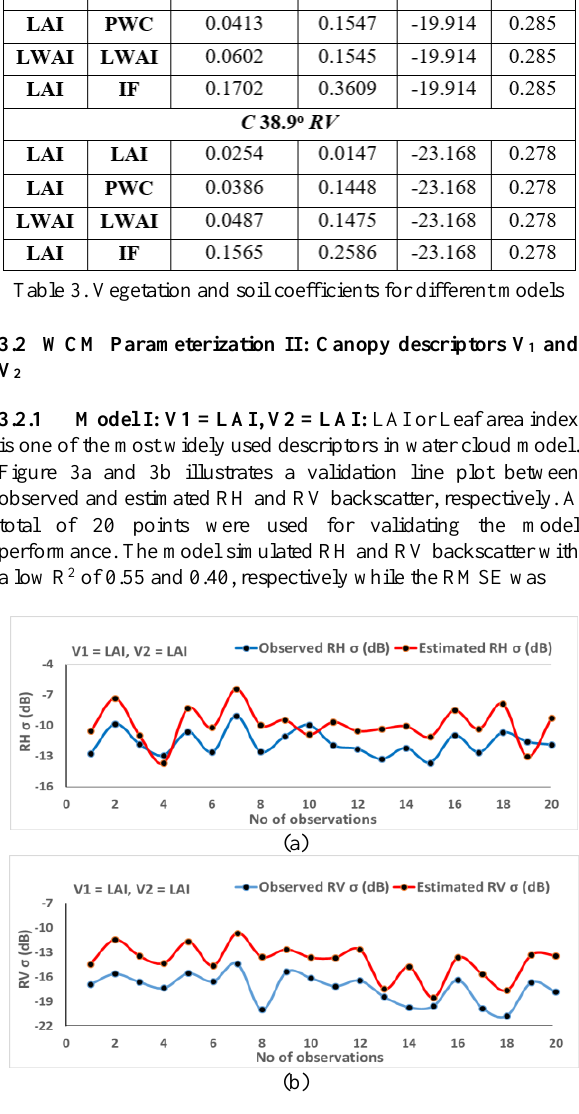
Figure 3. Observed v/s Estimated (a) RH and (b) RV backscatter for Model